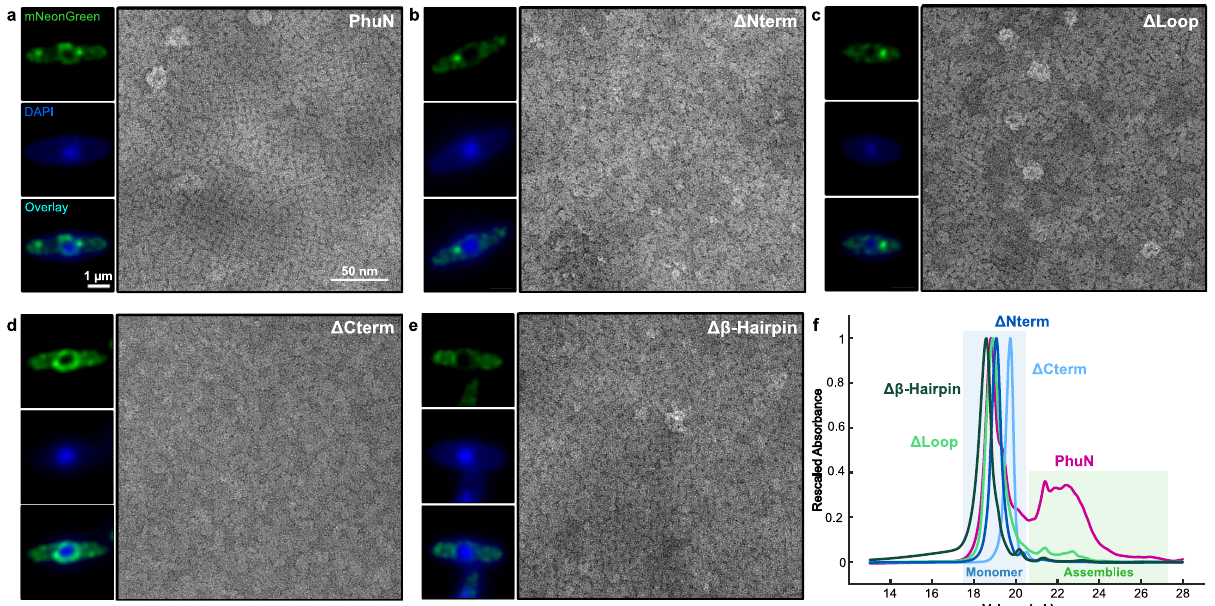
Fig. 4 | ϕ PA3 PhuN deletions show defects in shell integration in vivo and self- assembly in vitro. Live fl uorescence microscopy and negative stain EM micro- graphs of a full-length PhuN as well as the following PhuN deletions: b N-terminal tail(residues1 – 37), c Loop(residues272 – 291), d C-terminaltail(residues556 – 602), and e β -Hairpin (residues 111 – 126). Fluorescence microscopy images of PhuN or PhuN deletions were collected at 40min post-infection, deconvolved, and are displayedingreenwhiletheDAPI-stainedDNAisshowninblue.The1 µ mand50nm